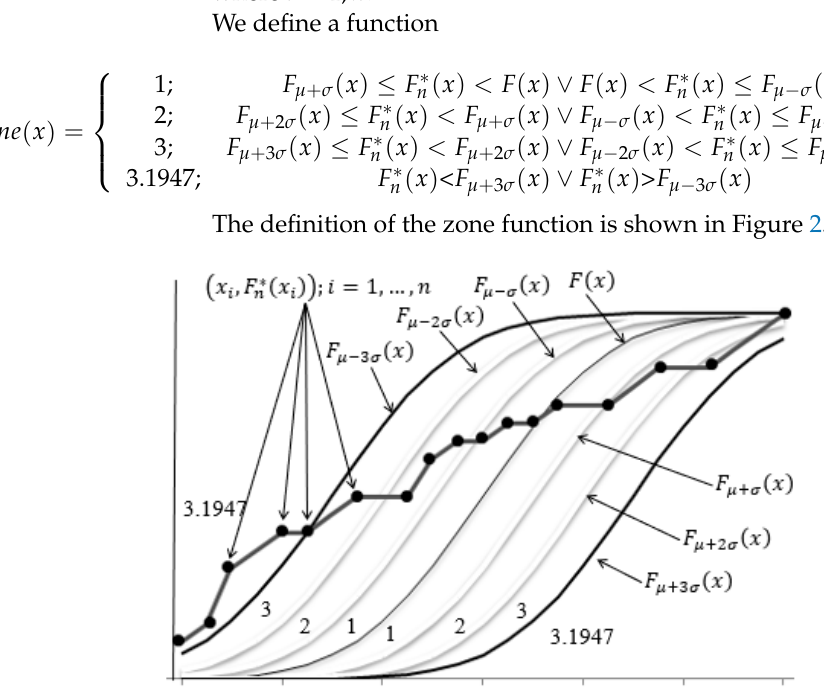
Figure 2. The zone function (1) illustrated.